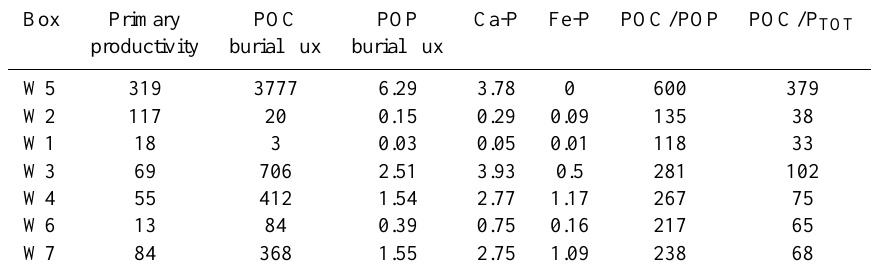
Table 4. Primary productivity (molm − 2 yr − 1 ), burial fluxes of POC, POP, Ca-P and Fe-P (mmolm − 2 yr − 1 ) and the molar ratios of POC/POP and POC/P TOT in the different areas of the proto-North Atlantic during OAE2 conditions in experiment E1 when